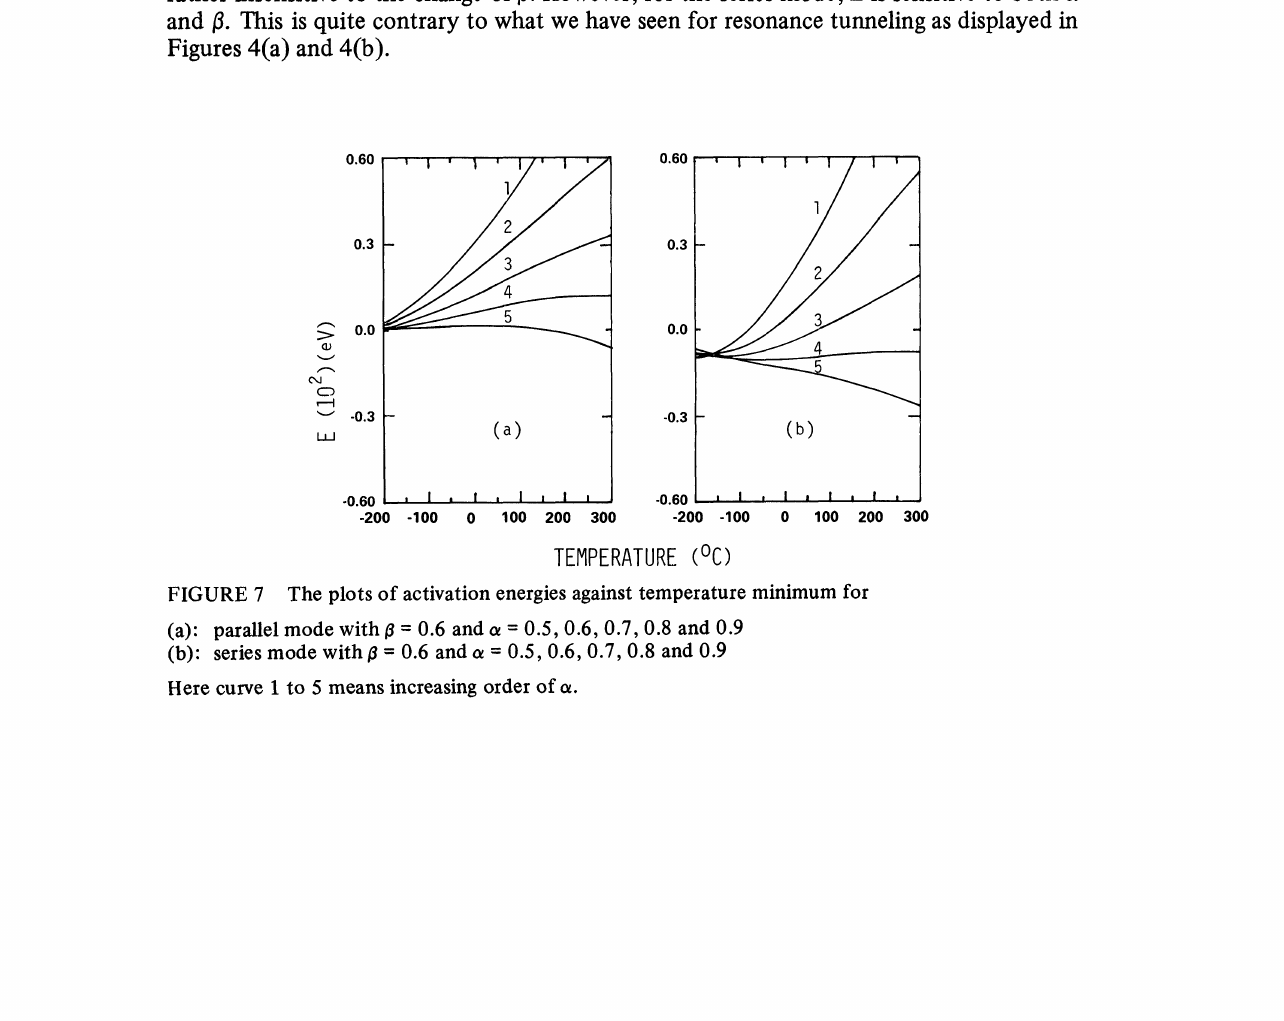
FIGURE 6 The plots of activation energies against temperature minimum for (a): parallel mode with a 0.6 and/3 05, 0.6, 0.7, 0.8 and 0.9 (b): series mode with a 0.6 and /3 0.5, 0.6, 0.7, 0.8 and 0.9. Please note that the curves for different /3’s were the same within the plotting scale. Curve to 5 means/3 increasing from 0.5 to 0.9.